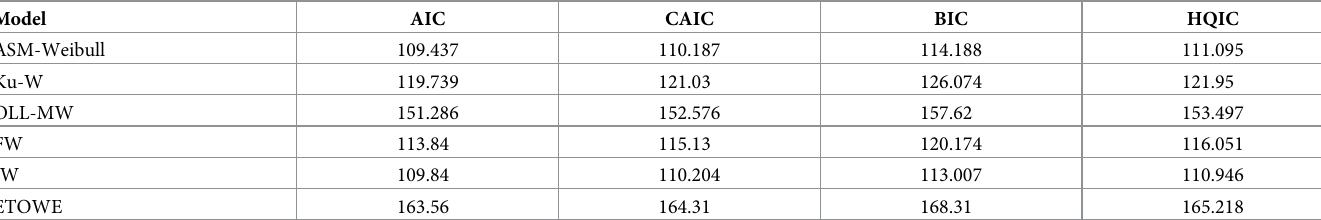
Table 10. Corresponding to the second COVID-19 data, the discrimination measures of the fitted models. Model